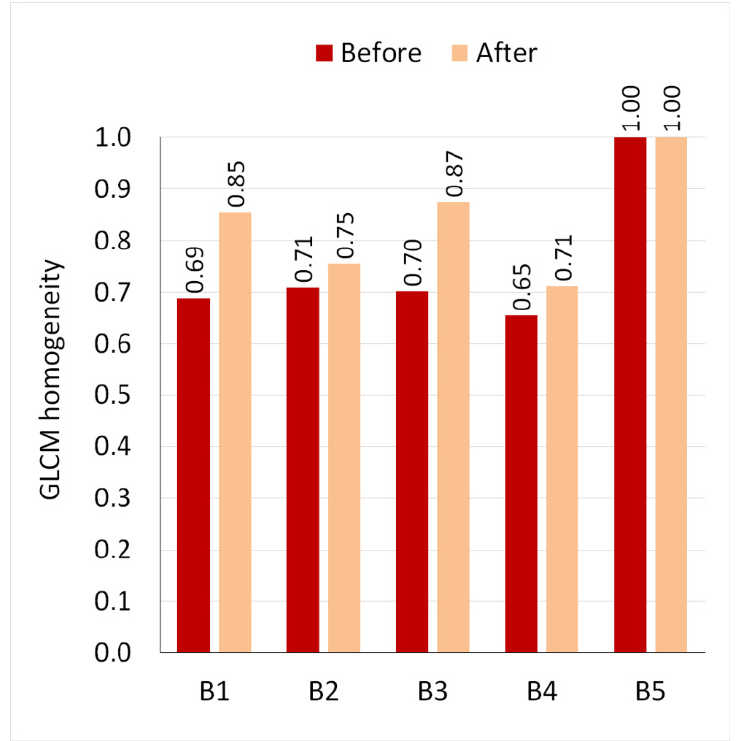
Figure 12 . Homogeneity in GLCM analysis before and after laser application . Figure 12. Homogeneity in GLCM analysis before and after laser